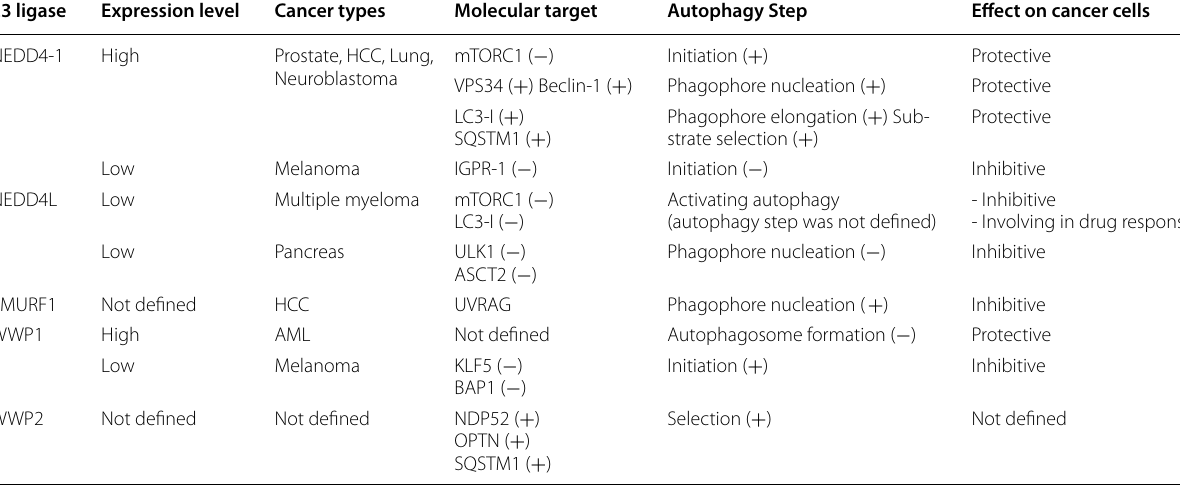
Table 1 The target substrates of NEDD4 E3 ubiquitin ligases in the autophagic process in cancer cells E3